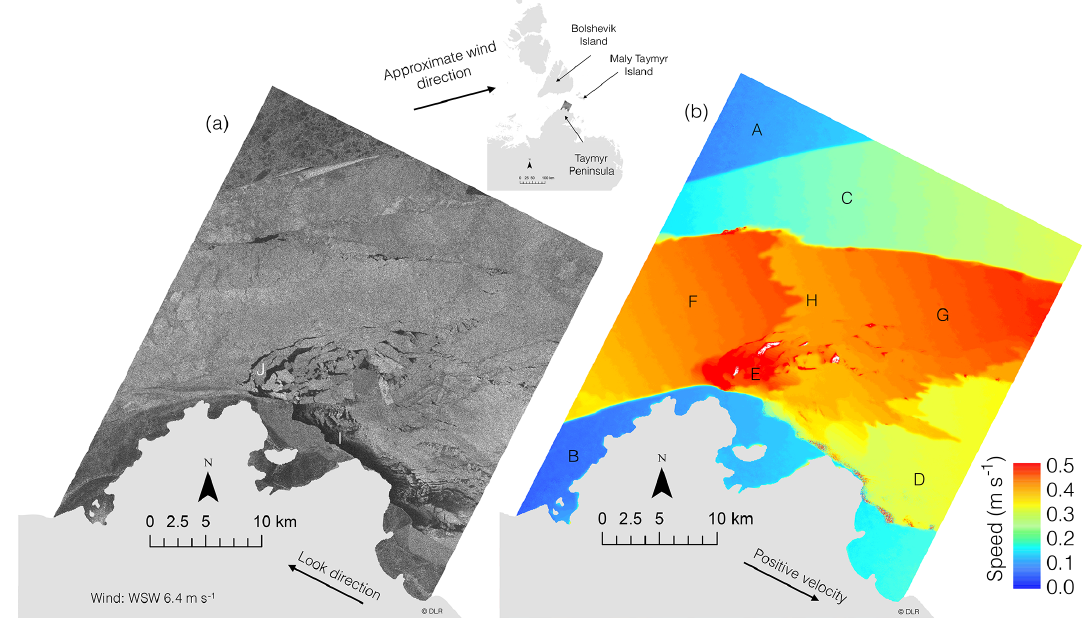
Figure 6. (a) TanDEM-X backscatter scene over Vilkitsky Strait 17 December 2013. (b) Look-directional component of InSAR-derived speed. Land is masked out in light gray. Wind at the time of the acquisition was roughly WSW at 6ms − 1 . Different zones are indicated by letters: (A–B) no drift in the look direction, (C–D) intermediate speeds, and (F–H) channel of high